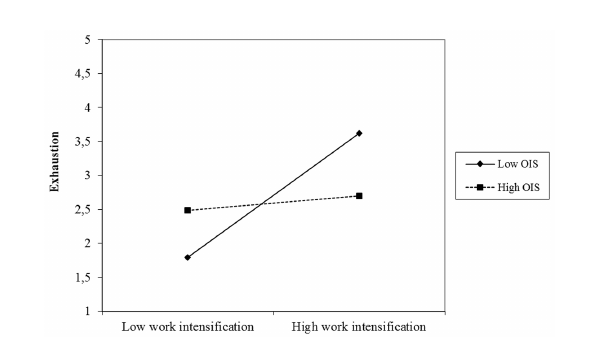
FIGURE 2 Moderation effect of organizational instrumental support on the work intensification – irritation relation.